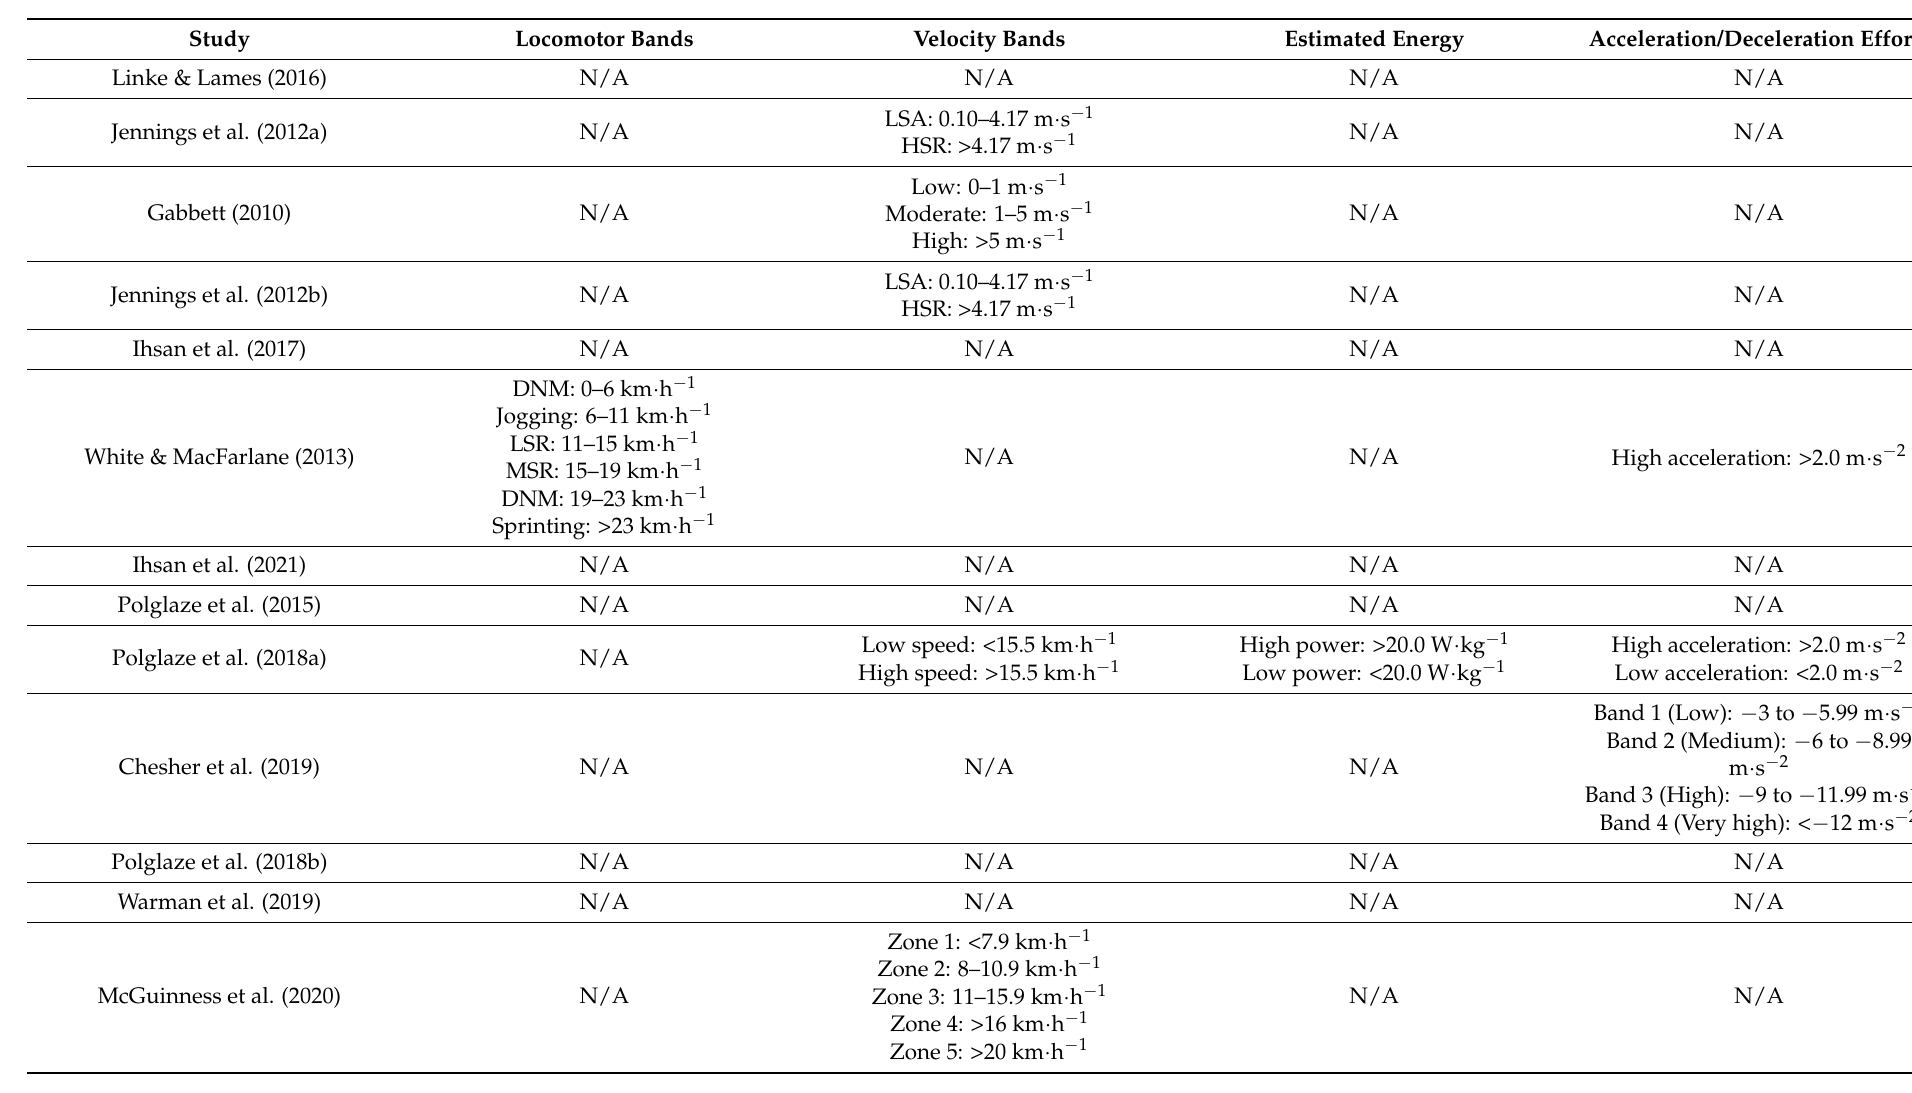
Table 2. Performance activity bands in studies that used global positioning system (GPS), active transponder devices, or Zephyr